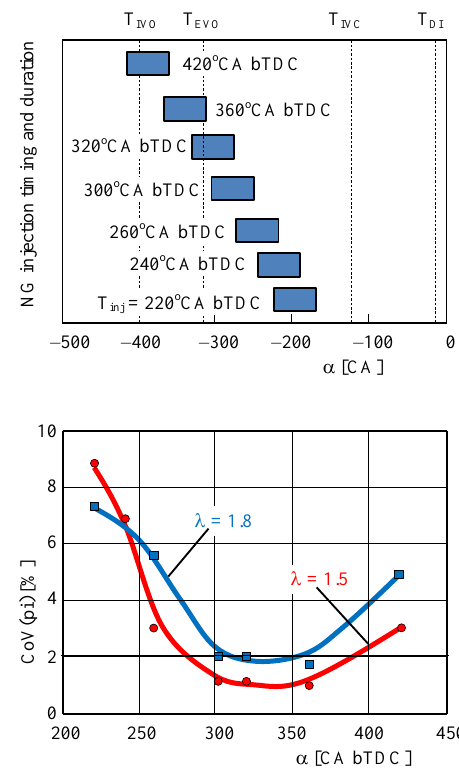
Fig. 1. Analysis of gas injection (a) and combustion process conditions (b): CNG injection into the inlet channel and DF injection into the cylinder at different values of the excess air coefficient